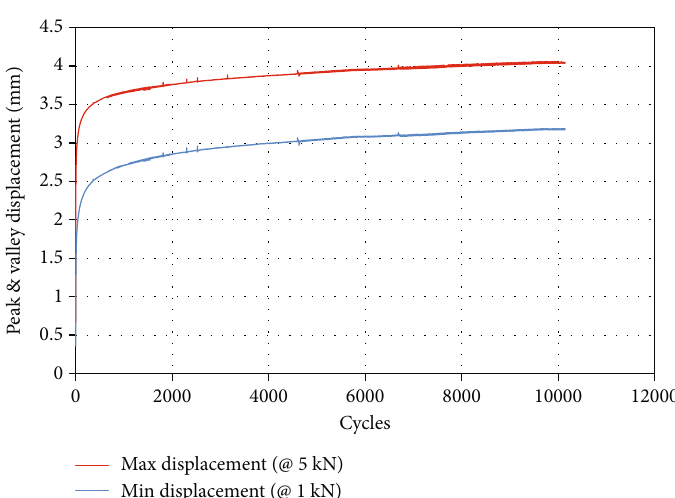
Figure 9: Ratcheting test results